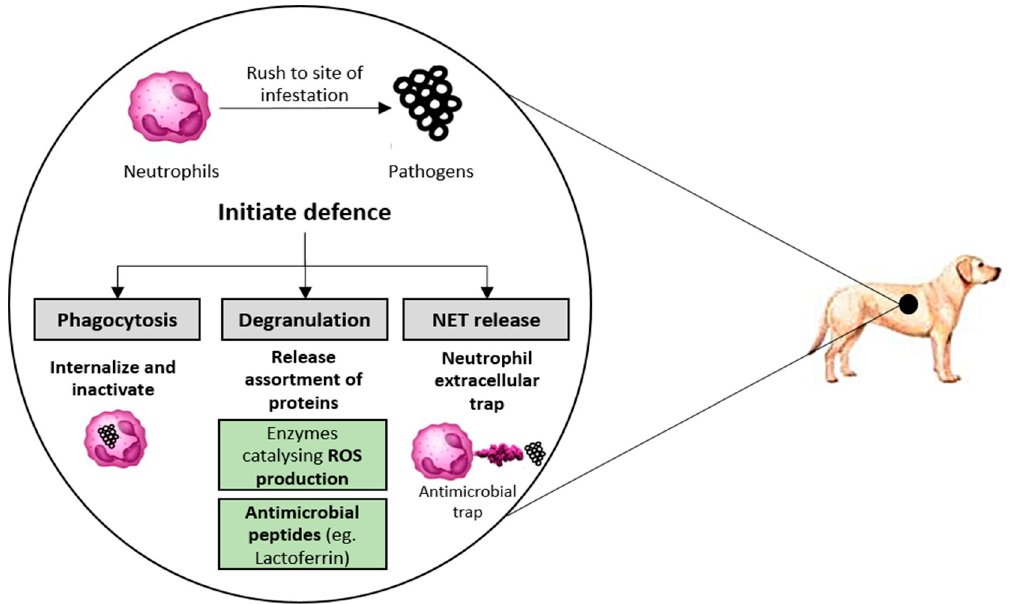
Figure 6. Defense mechanism of neutrophils. Source: Adapted from Tsumbu et al. [16], Paul et al. [17], and Perobelli et al. [44].